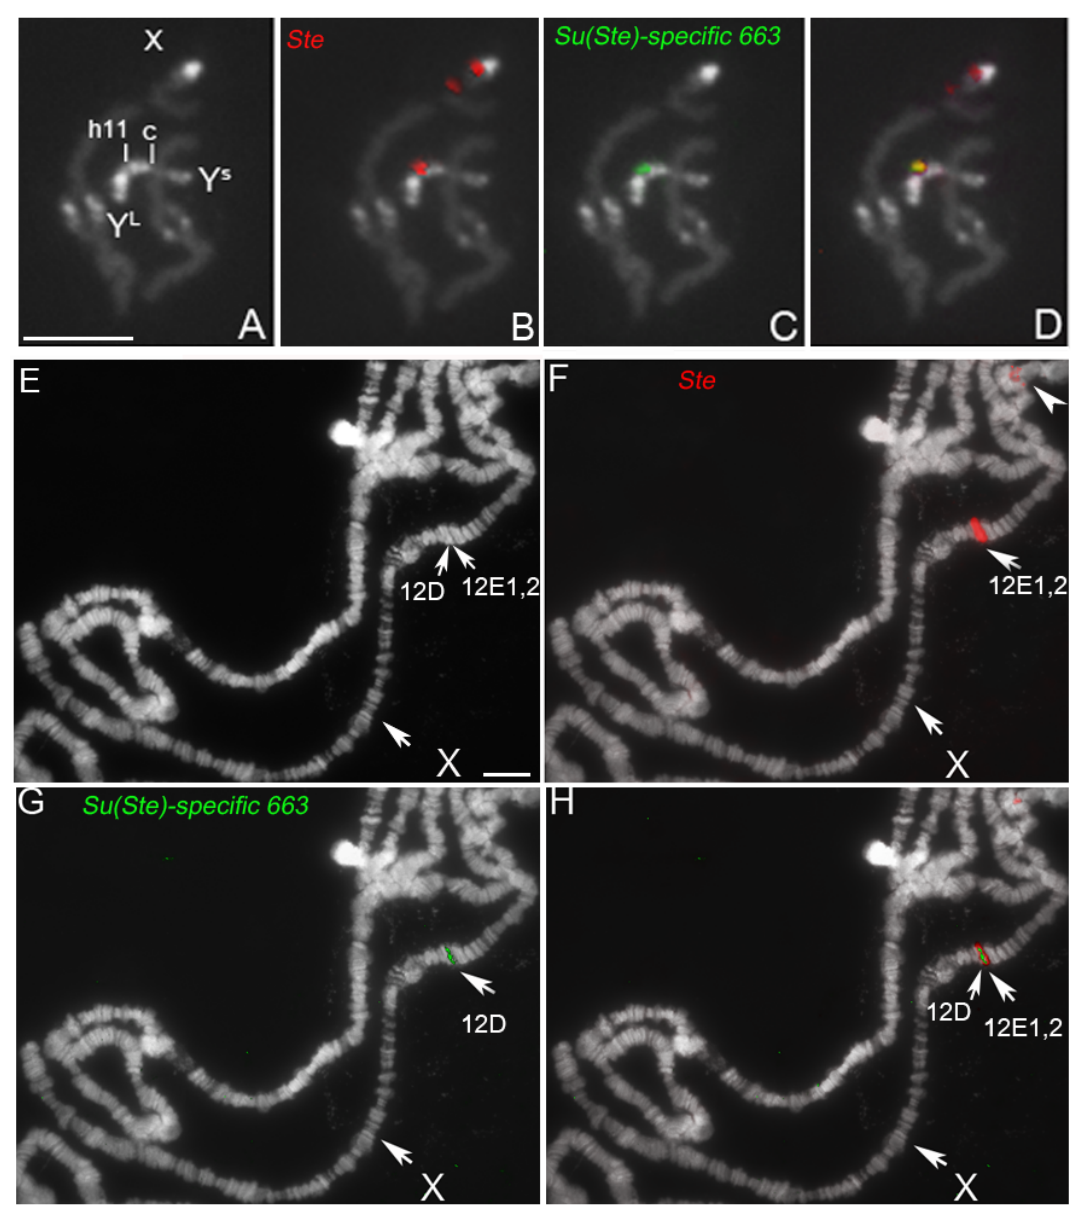
Figure 3. ( A – D ) Localization by fluorescence in situ hybridization of pUSTE6-Cy2 labeled (red) and Su(Ste) -specific 663-FluorX labeled (green), on mitotic chromosomes of D. melanogaster , stained with DAPI. ( B ) FISH signals of pUSTE6 on the chromosome X in the Ste eu and Ste het loci and in the h11 region on the Y chromosome; ( C ) FISH signal of Su(Ste) -specific 663 in the h11 region on the Y chromosome; ( D ) a merge of the two hybridization patterns; the yellow signal on the merged figure indicates the co-localization of the two probes. Scale bar indicates 5 µm. ( E – H ) Localization of the same probes on the polytene chromosomes; ( F ) hybridization signals of pUSTE6 in the chromocenter (arrowhead) corresponding to X heterochromatic Ste locus and (arrow) in the 12E1,2 euchromatic region; ( G ) Su(Ste) -specific 663 hybridization signal in the region between 12D and 12E1,2 bands; ( H ) a merge of the two hybridization patterns. Scale bar indicates 10 µm.